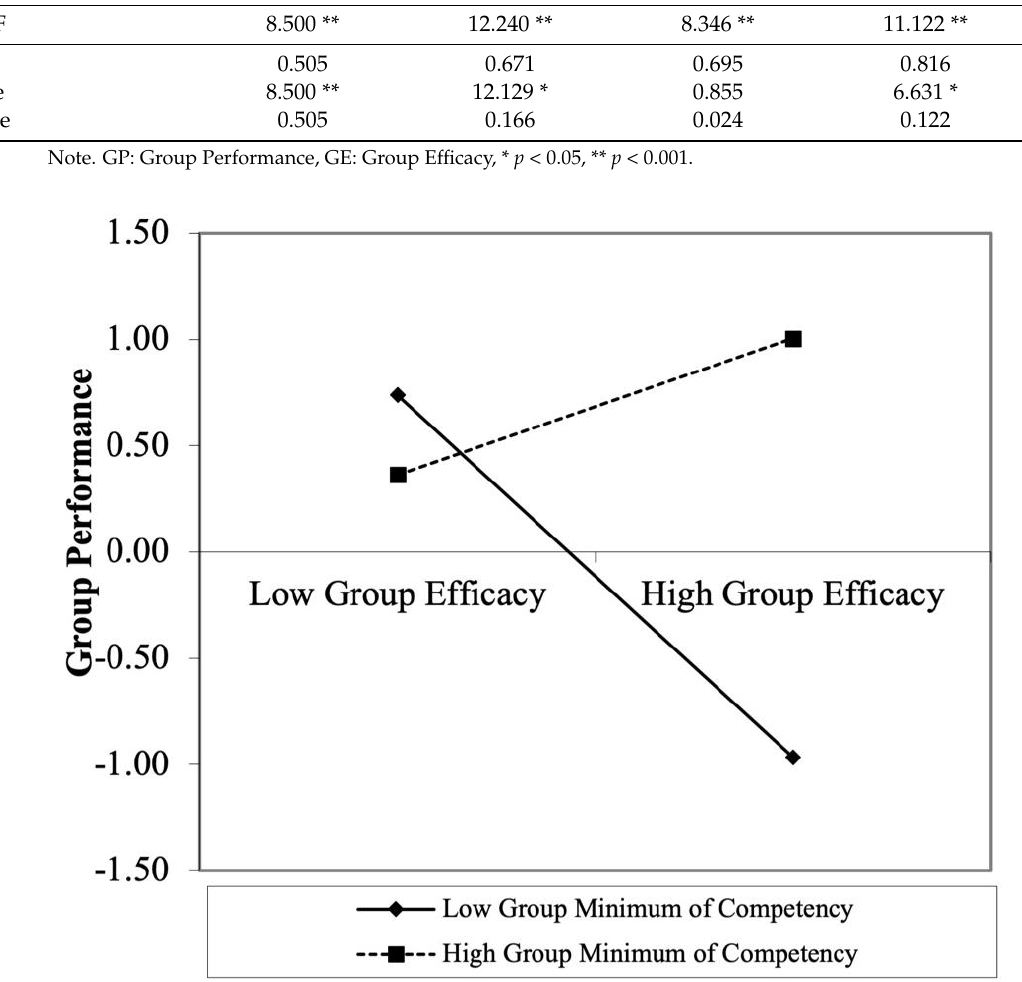
Figure 4. Moderating effect of group minimum competency on the relationship between group efficacy and performance.